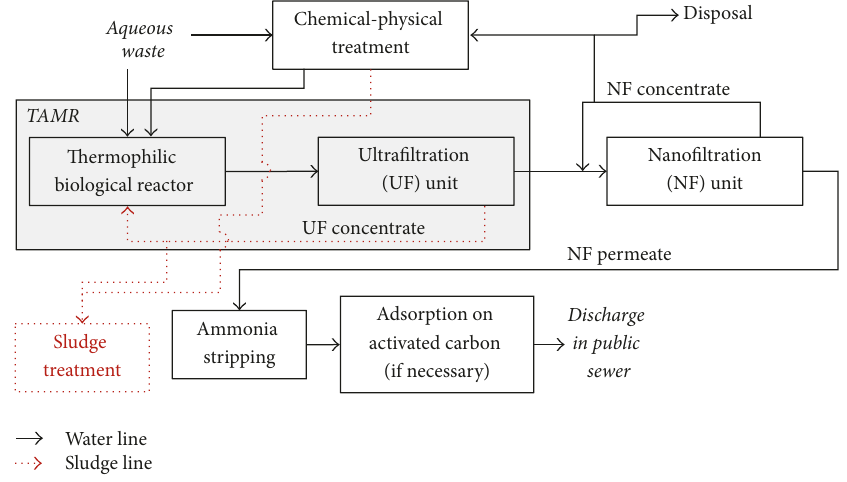
Figure 1: Process scheme of the studied